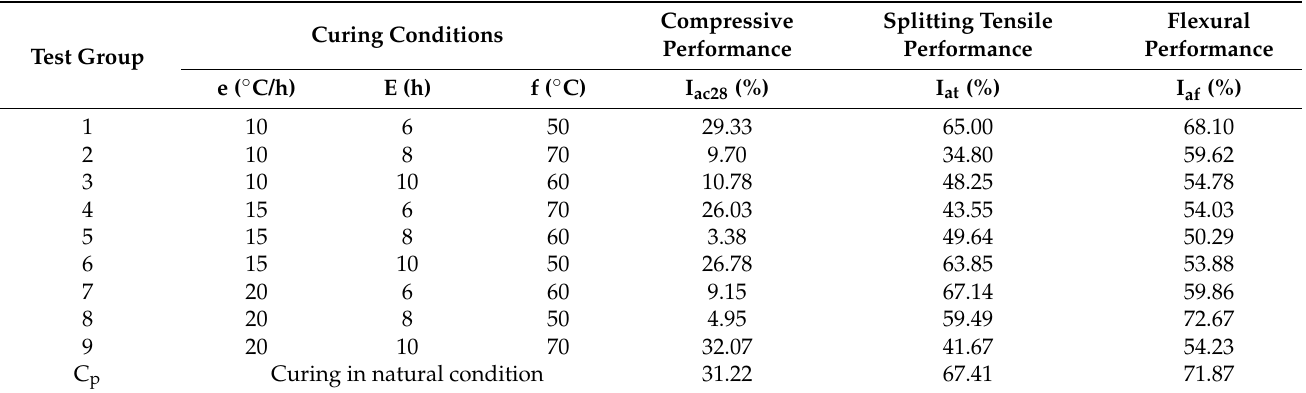
Table 10. Orthogonal experimental table of various test group designs, curing conditions, and ani- sotropy coefficient of mechanical performance.